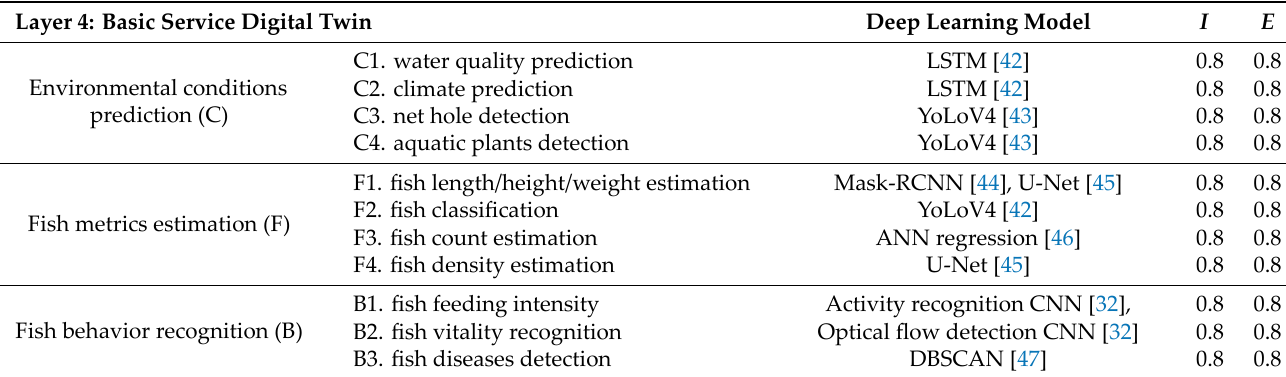
Table 3. Layer 4 of the Digital Twins as a basic services provider.